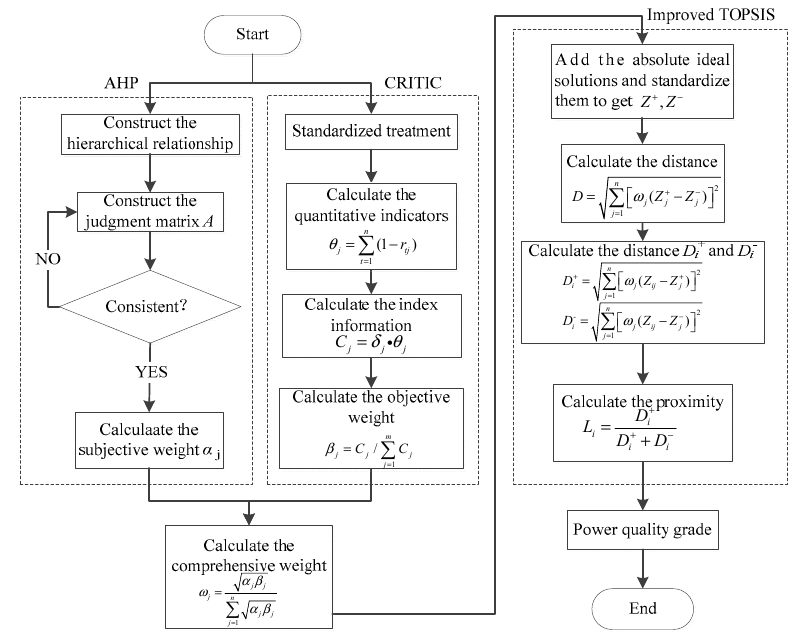
Figure 4. The flow chart of power quality analysis and evaluation.